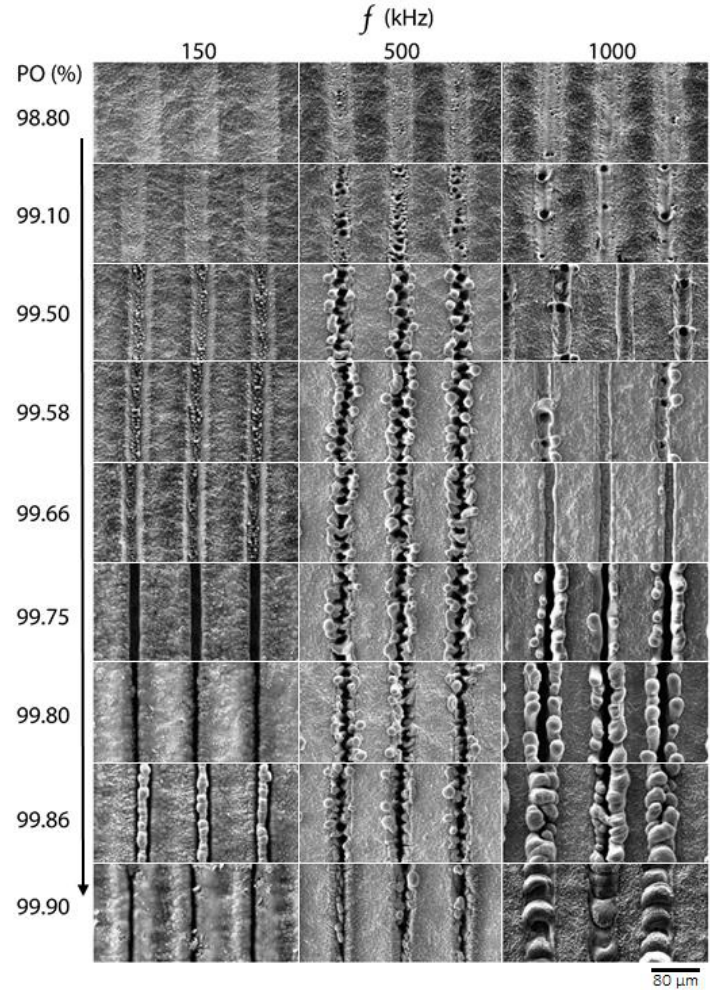
Figure 1. SEM images of structures on Ti alloy fabricated at 150 kHz, 500 kHz, and 1 MHz.